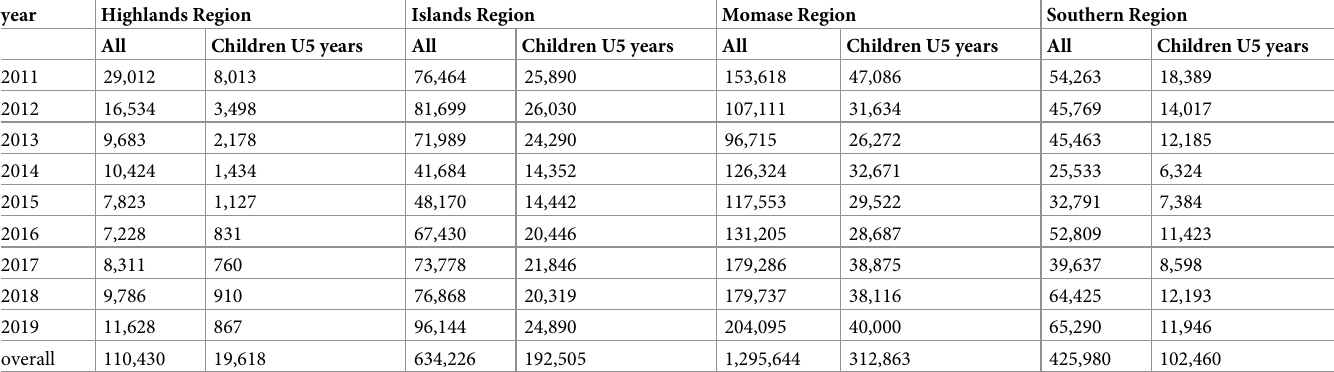
Table 2. Estimates of malaria cases unseeking care by region in PNG